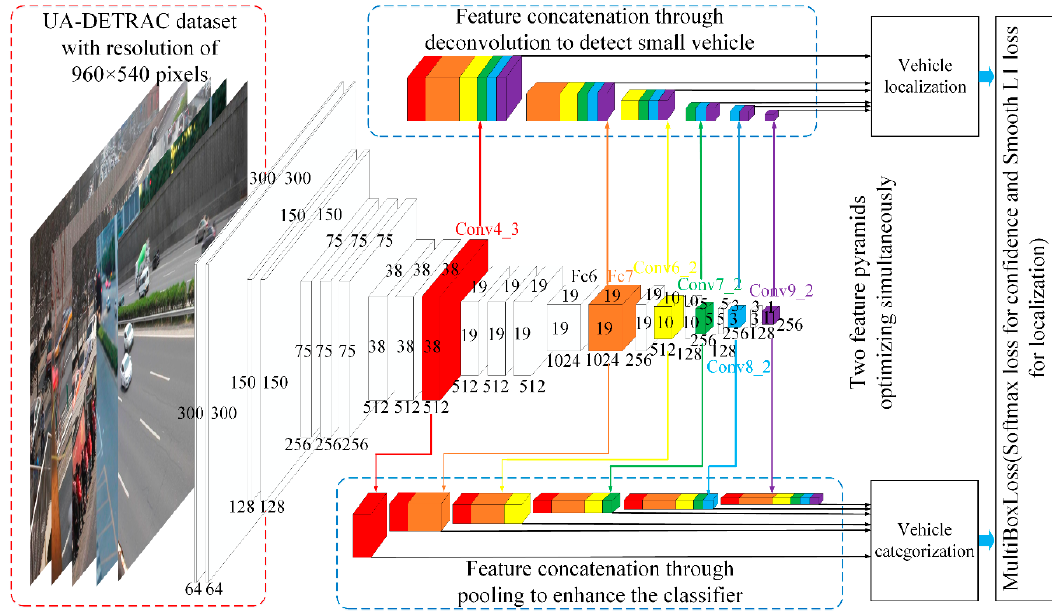
Figure 2. Training architecture of DP-SSD for vehicle detection. Our DP-SSD model utilizes conventional SSD, but divides the feature pyramid for detection into two parts: feature pyramid for localization and feature pyramid for classification. For localization, we enhance the representation power of lower layers by concatenating feature maps through deconvolution. The classification feature pyramid concatenates feature maps of the upper layers through pooling.